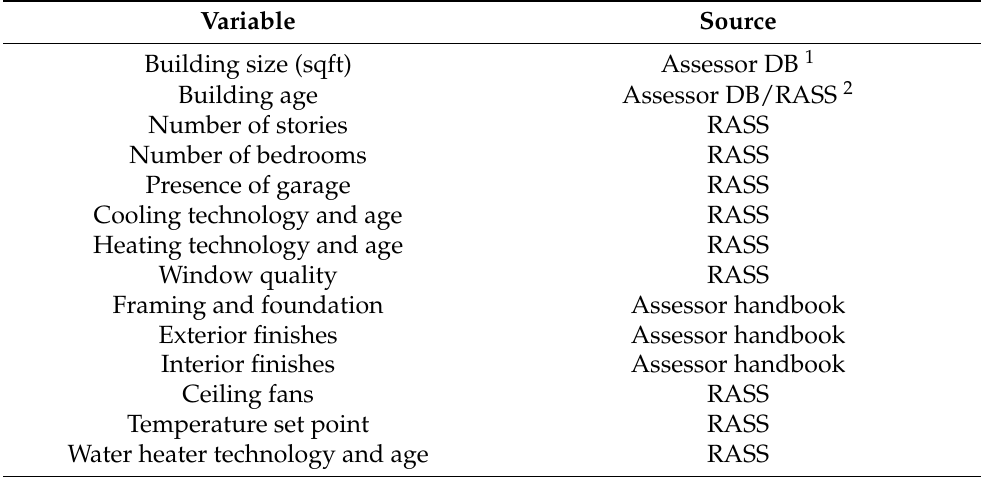
Table 2. Some appliance distributions and material properties of the buildings required in the physical model and sources